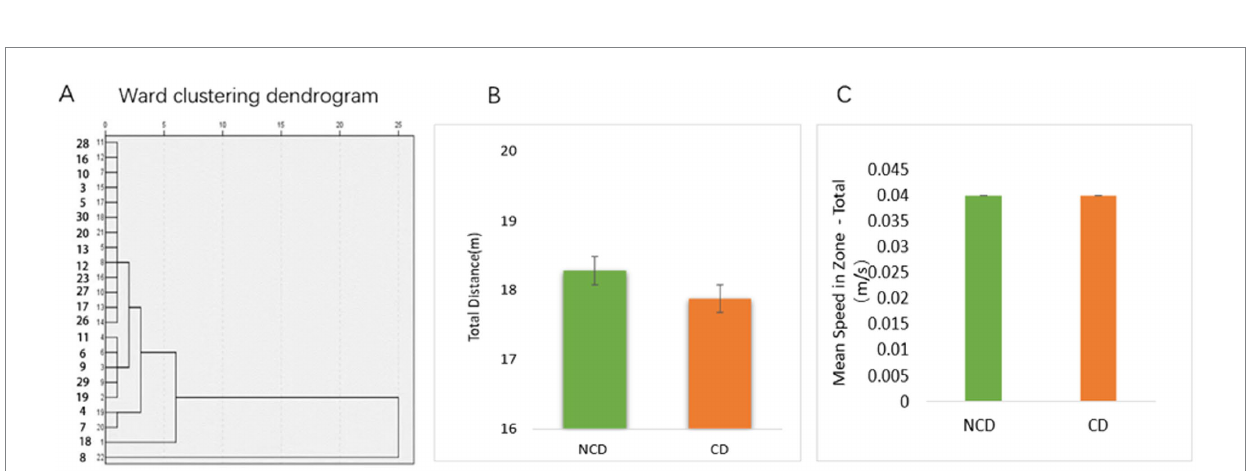
FIGURE 2 New object recognition in diabetic peripheral neuropathy combined with cognitive impairment (CD) and diabetic peripheral neuropathy non-CD rats. (A) Hierarchical cluster analysis of the dendrograms. Results of the hierarchical cluster analysis based on NORT results. DPN rats were divided into cognitive dysfunction group (Group_CD) and no cognitive dysfunction group (Group_NCD). (B,C) The NORT test was followed by an absentee field experiment to test the locomotor ability of the rats ( p >